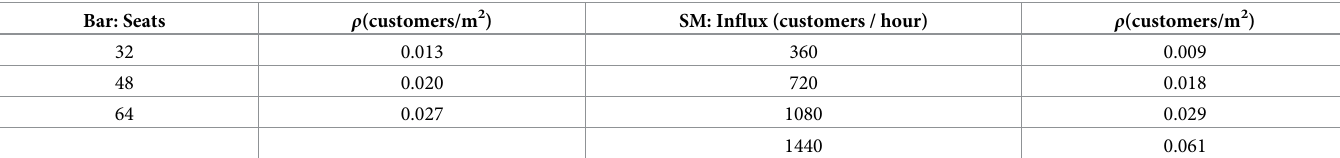
Table 1. Average customer density in bars with varying number of seats and in supermarkets with varying customer influx. In SM, increase in ρ from larger influx is not linear as the system approaches jamming due to waiting times at cashiers. Bar: